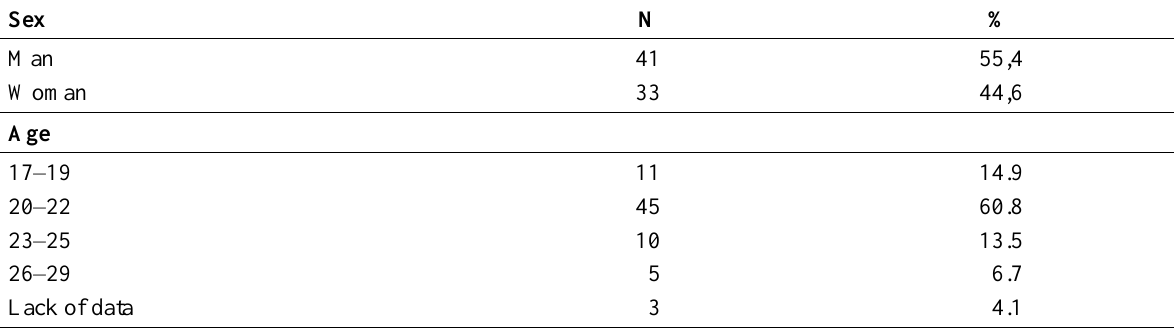
Table 1. Demographic features of the research group (N=74) Sex N % Man